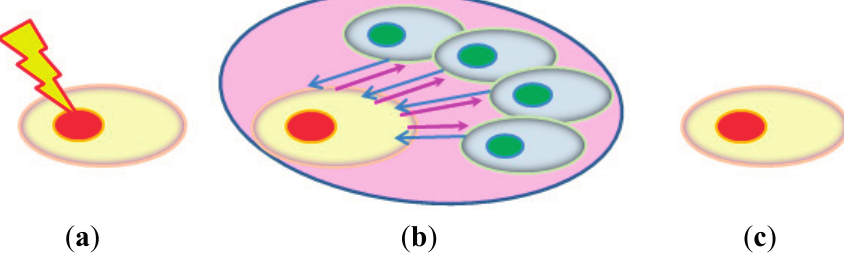
Figure 4. The co-culture method used by He et al. [21] to study the rescue effect. Before co-culturing, the irradiated and bystander cells were stained with the red fluorescent dye DiIC 18 and the green fluorescent dye DiOC 18 , respectively. ( a ) Cell irradiation before co-culturing; ( b ) co-culturing to allow communication of bystander signals (pink arrows) and rescue signals (blue arrows) between the irradiated cell (with red nucleus) and the bystander cells (with green nuclei); and ( c ) irradiated cells washed away from the cell co-culture for examination after the desired co-culture